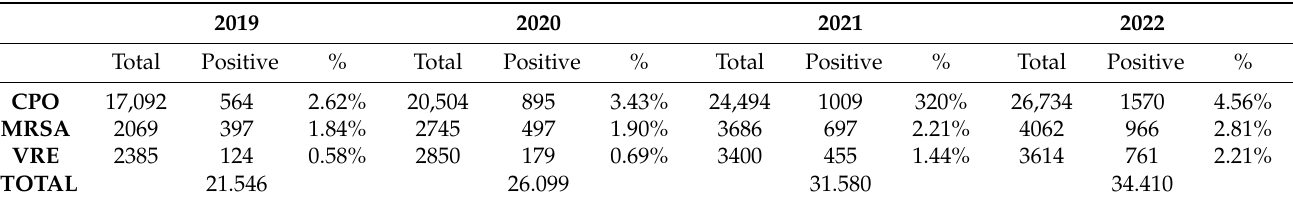
Table 1. Positive resistance percentages divided by antimicrobial substances over the four years.